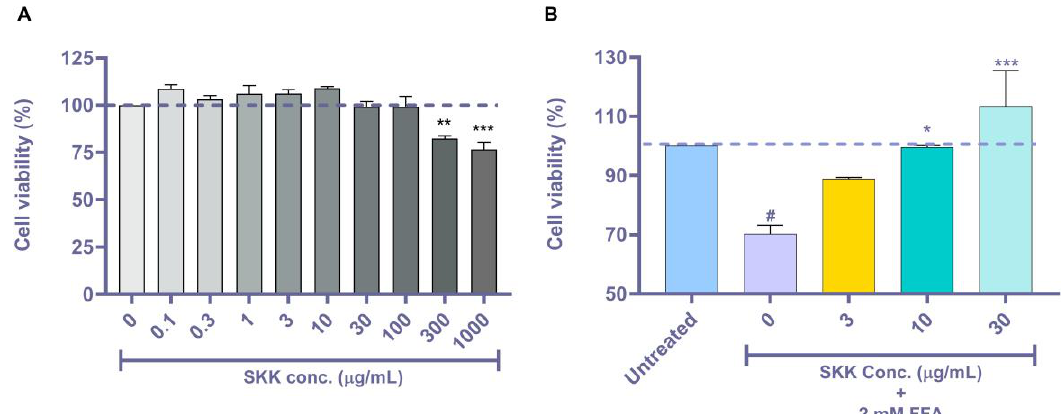
Figure 2. Effect of SKK on HepG2 cell viability. ( A ) Cytosafety profiling of HepG2 cells post-SKK